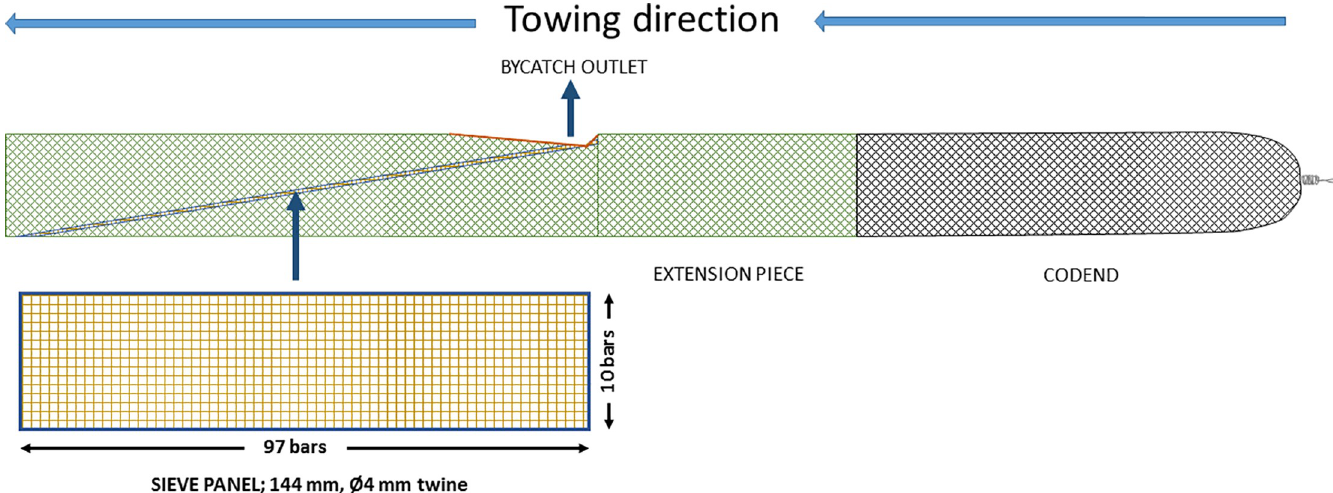
Fig 2. Illustration of a typical sieve panel and codend design (side